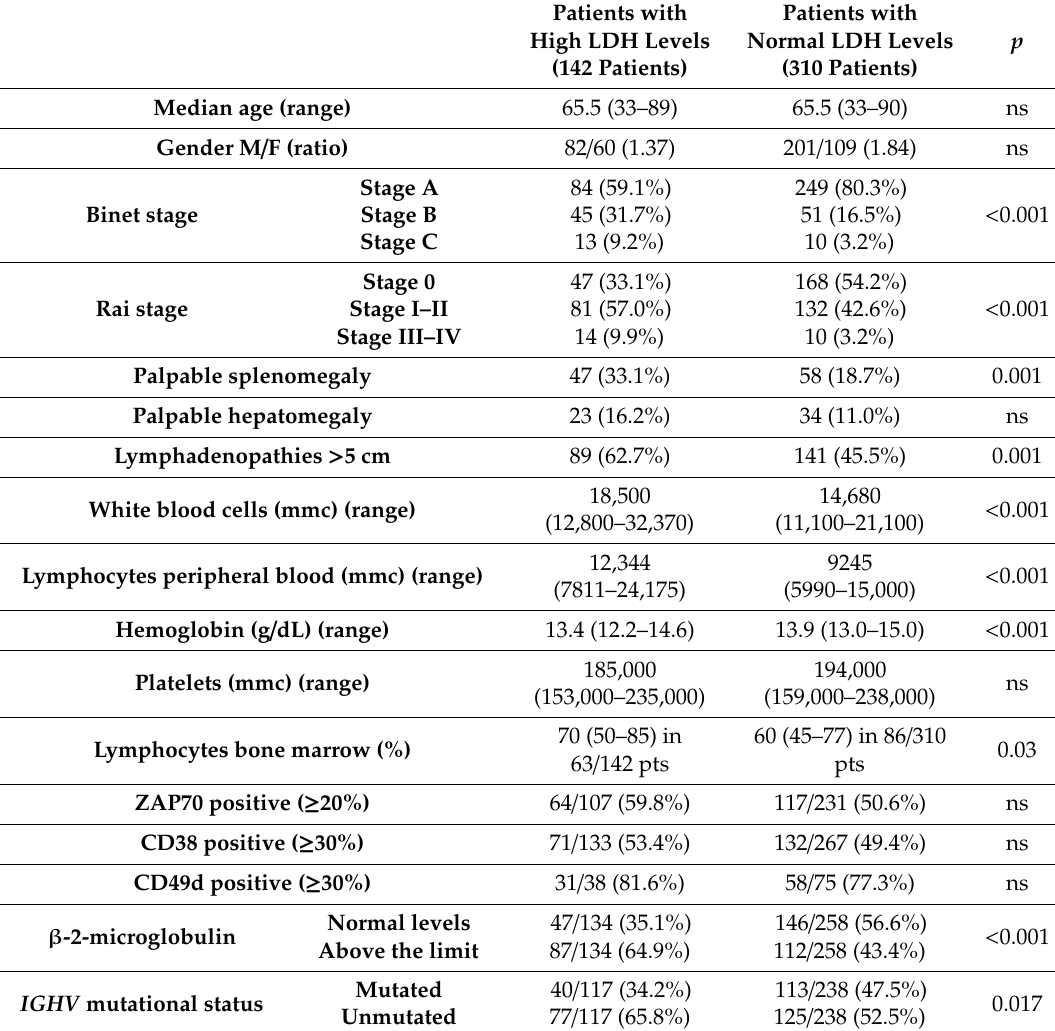
Table 2. Baseline characteristics at diagnosis of CLL patients with + 12 divided in two subgroups according to lactate dehydrogenase (LDH)